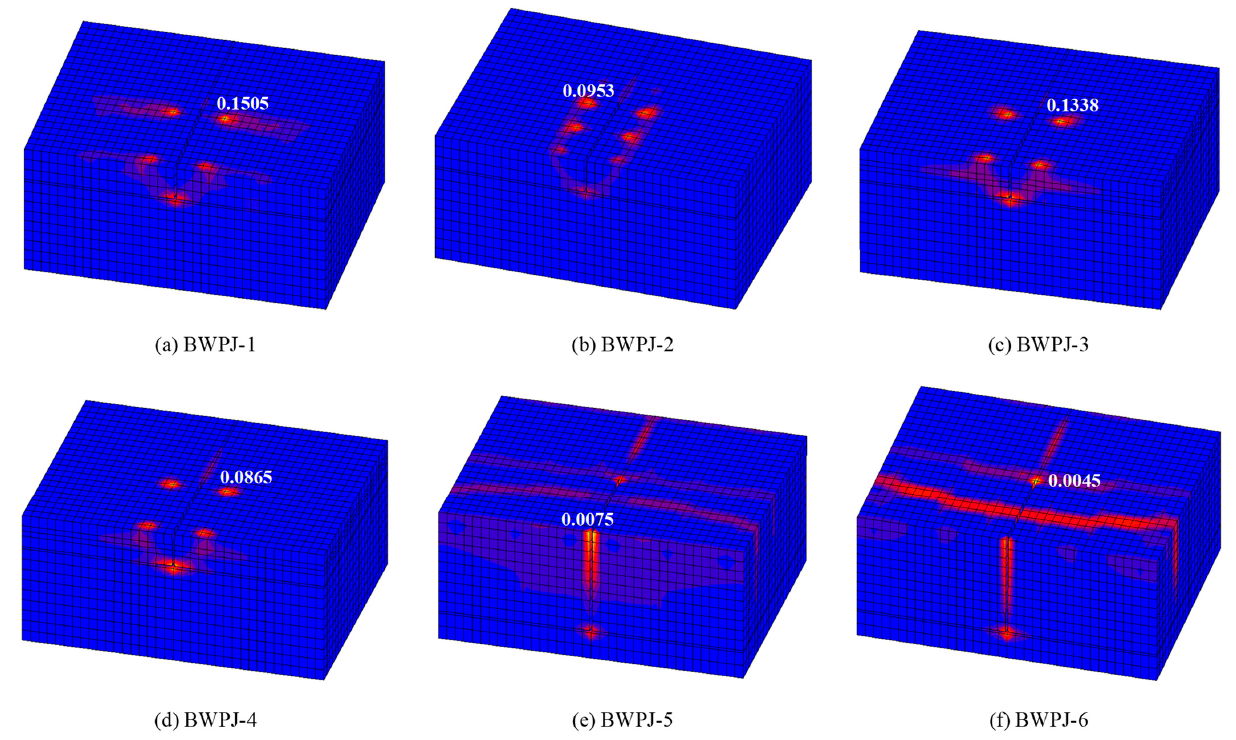
Figure 16. Equivalent cracking strain of the concrete wall at the failure point.